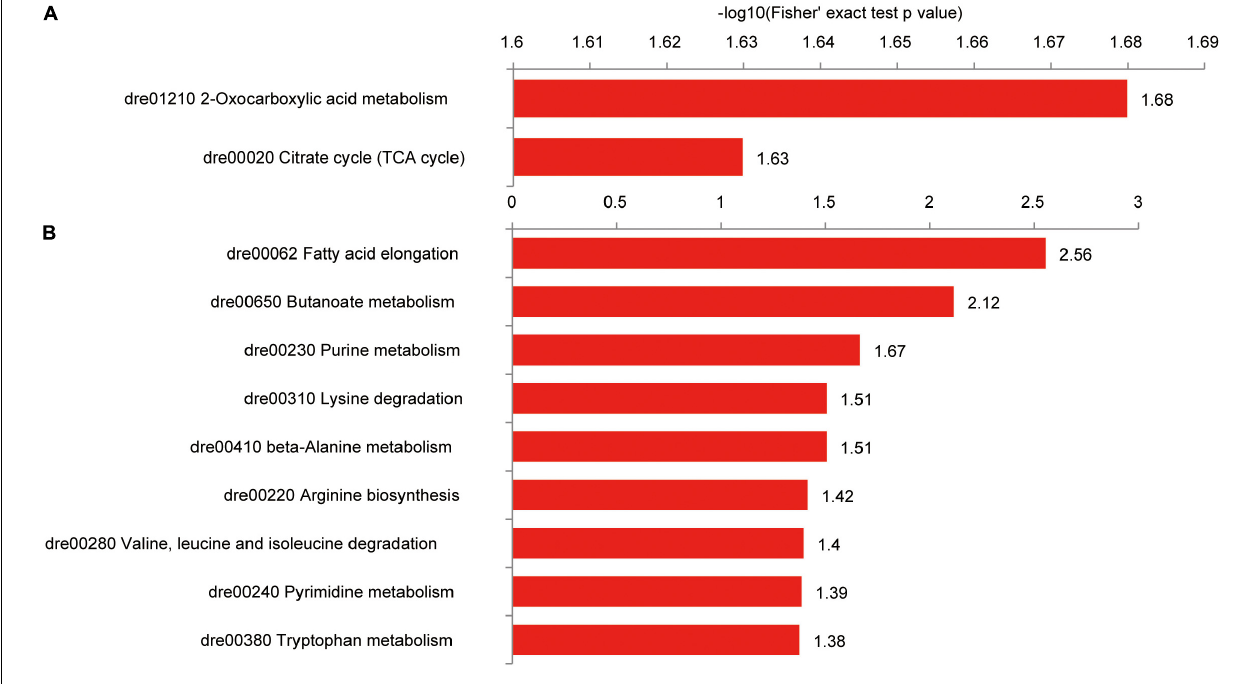
FIGURE 9 | KEGG pathways of differentially succinylated proteins in the intestine of zebrafish fed the CK or S0.15 diet for 4 weeks. (A) Pathways involved in proteins with increased succinylation. (B) Pathways involved in proteins with decreased